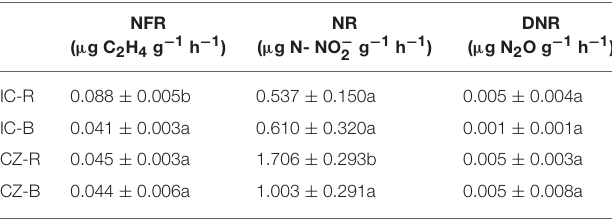
TABLE 5 | Multivariate analysis of variance (MANOVA) ( F -value, P -value) of mixed effects of plant species (P), rhizosphere (R) and their interaction on the abundances and transcripts of functional